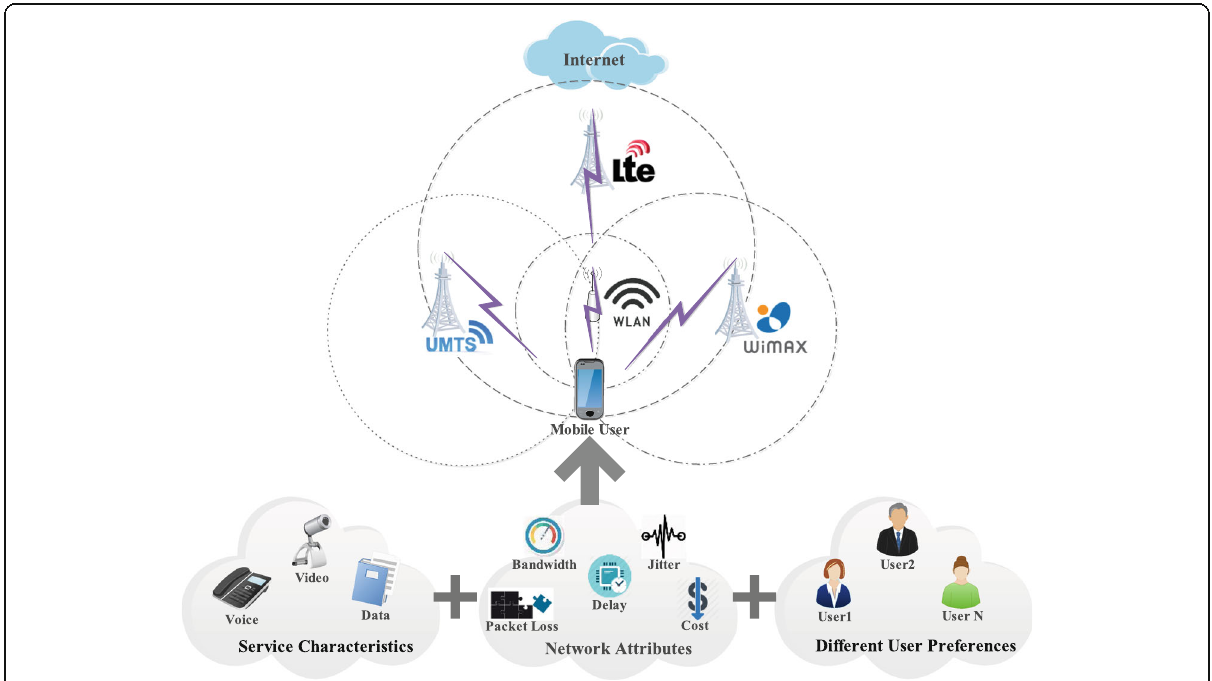
Fig. 2 Scenario with HWNs for network